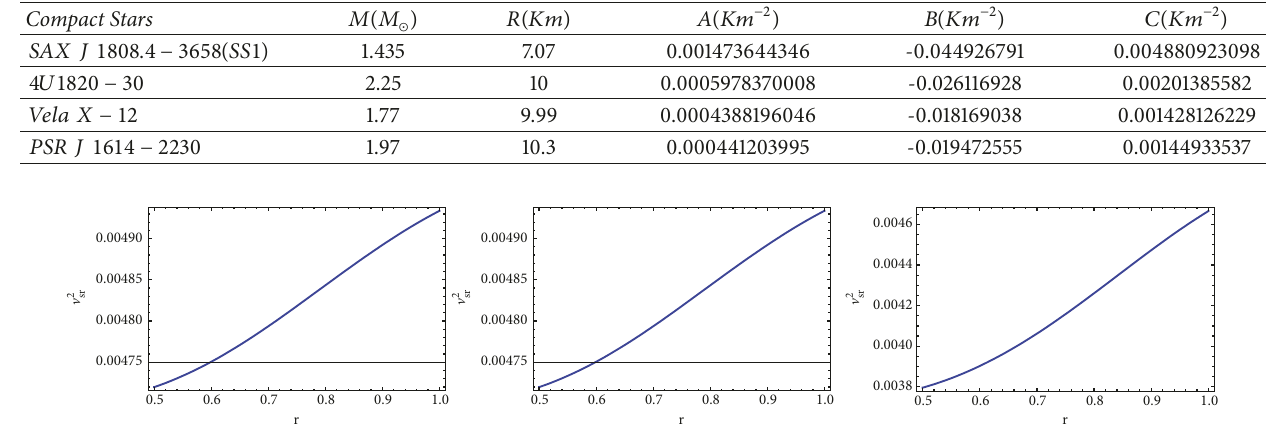
Figure 15: This figure represents the variation of V 2 𝑠𝑟 versus 𝑟 (km) for the strange star taking 𝛽 = 1 , 𝛽 = 2 , and 𝛽 = 3